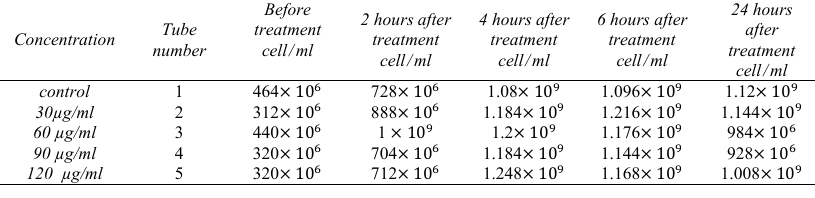
Table 5: Mean optical density reflecting antimicrobial activity exhibited by Nisin